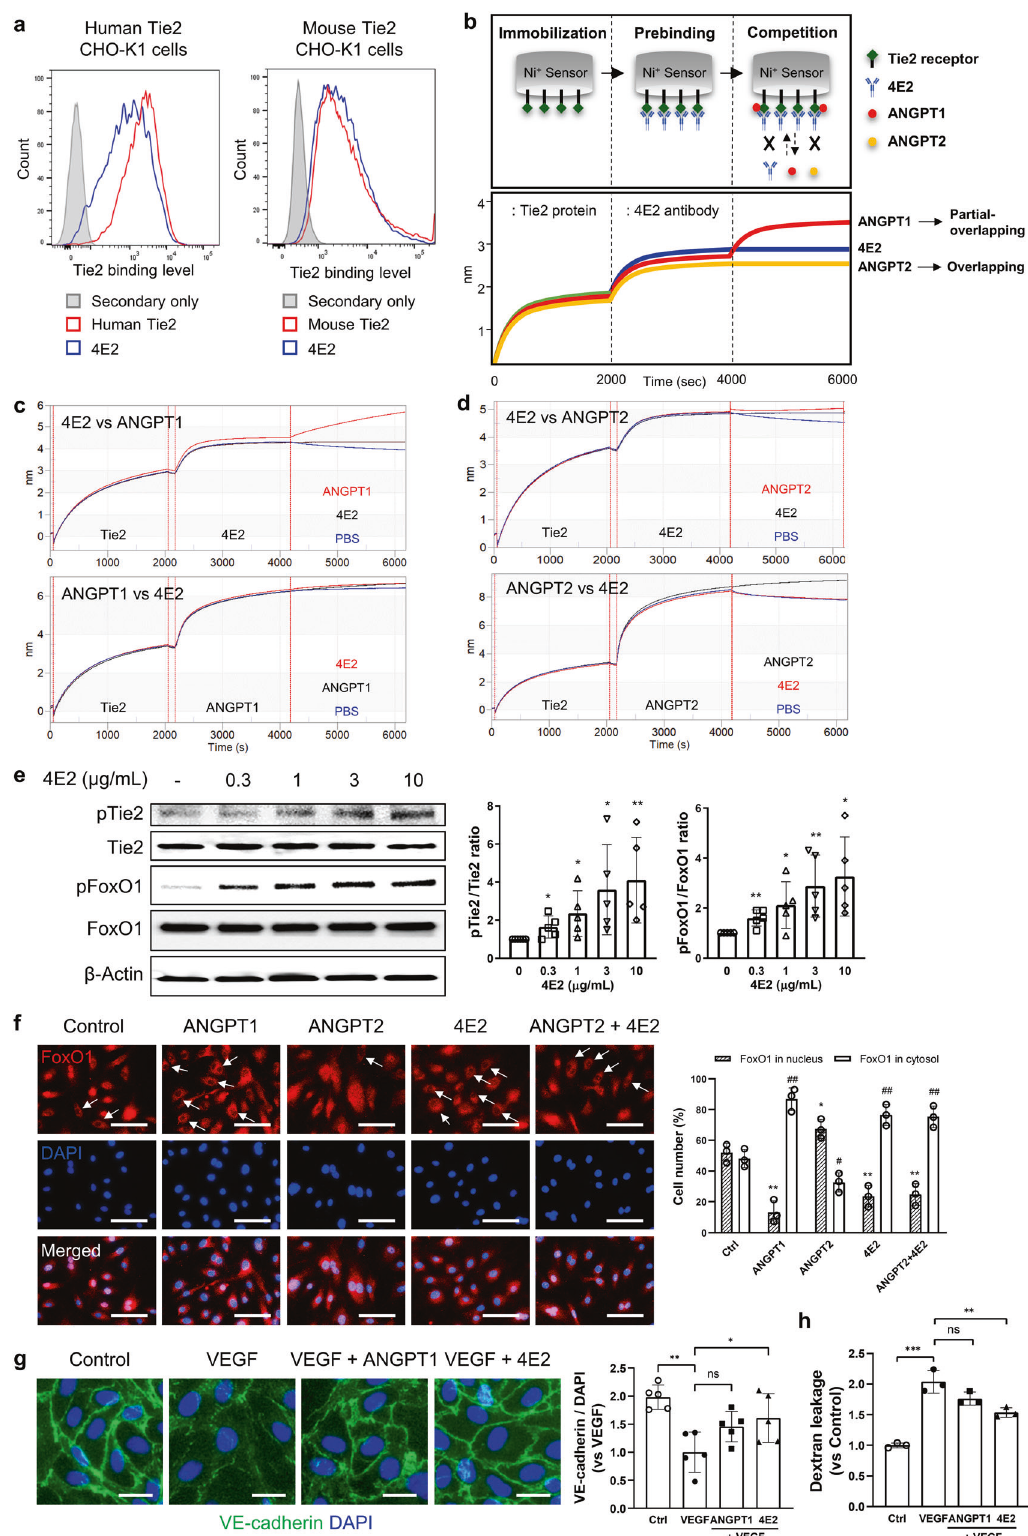
decreased vessel branching (Supplementary Fig. 4e – g). These fi ndings indicate that the major initial vascular change is temporally progressive remodeling based on vasodilation and vasoconstriction in the GBM invasion